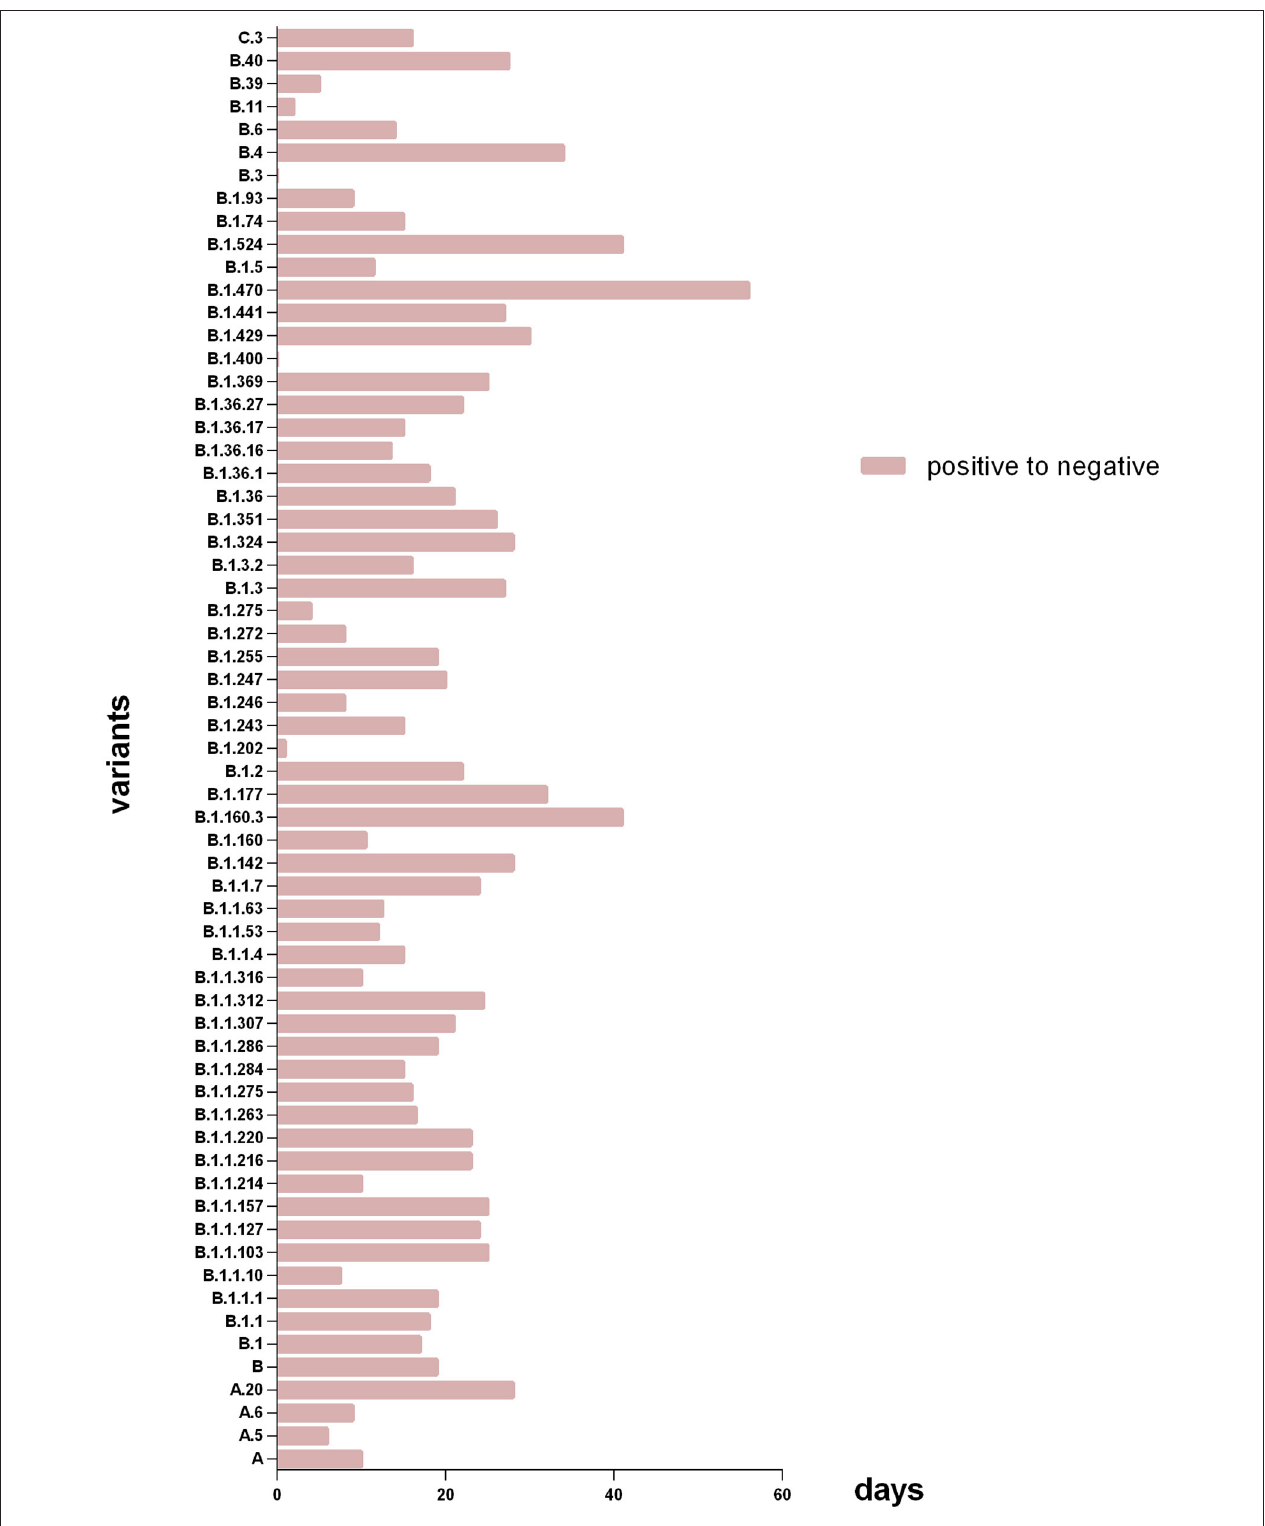
FIGURE 3 | Days of patients with different variants from SARS-CoV-2 RNA positive to negative. The X axis refers to days of patients with different subtype spent in SARS-CoV-2 RNA turning negative; the Y axis refers to the different virus subtype that involved in this study. Patients with lineage B.1.470 had the longest median time of SARS-CoV-2 RNA turning negative, and the shortest were B.3 and B.1.400.